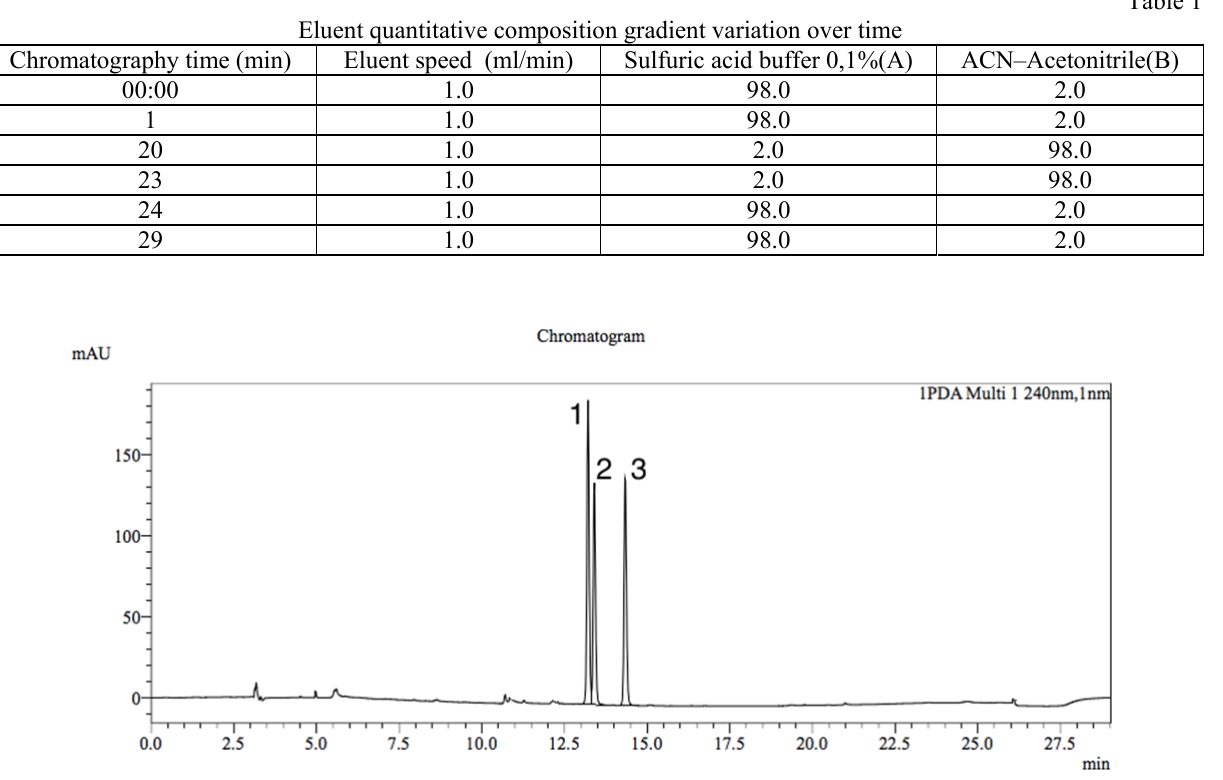
Fig. 1. Medicinal products mixture (RSAET2) chromatogram: 1 – Alprazolam (retention time 13,216 min.);